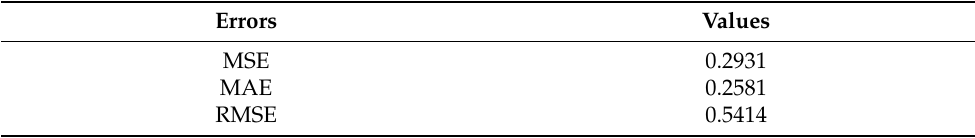
Table 3. MSE, MAE, and RMSE for the prediction of solar radiation (winter